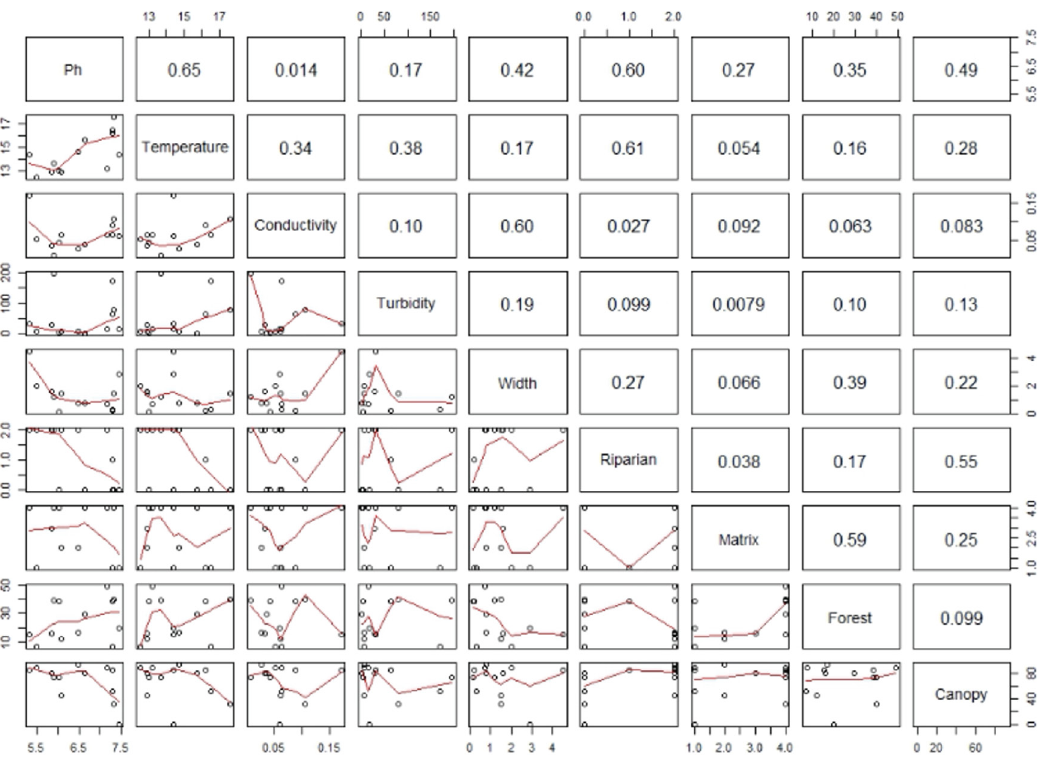
Figure 2. Pearson’s correlation analysis among the explanatory variables (riparian vegetation, conductivity, with, canopy coverage, type of substrate, the predominant types of matrix surrounding the rivers, the proportion of forest habitat and